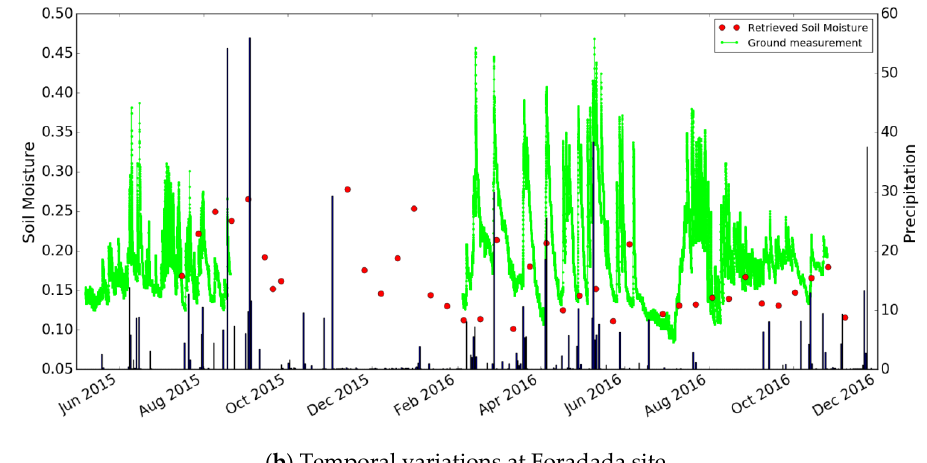
Figure 9. Temporal variations in ground measurements and S1 estimations of soil moisture at the Agramunt site ( a ) and Foradada site ( b ).